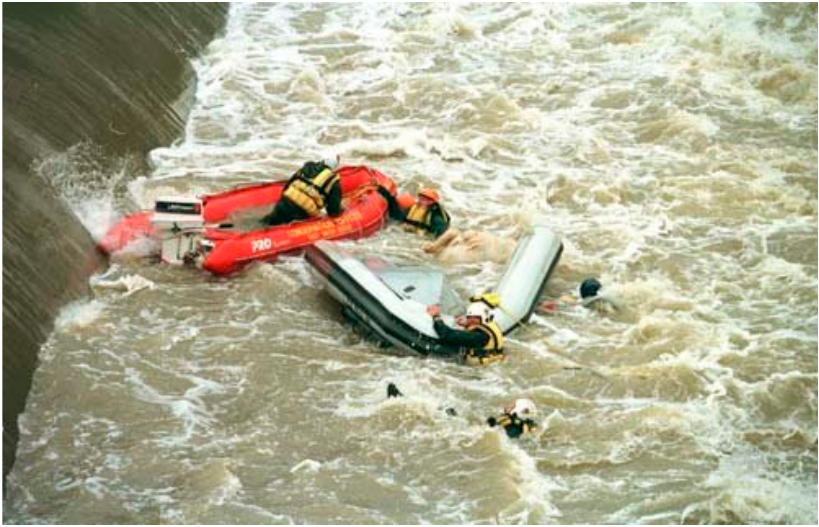
Figure 1. At least five lives in danger below a low-head dam [6]. With permission from C.R. Don-